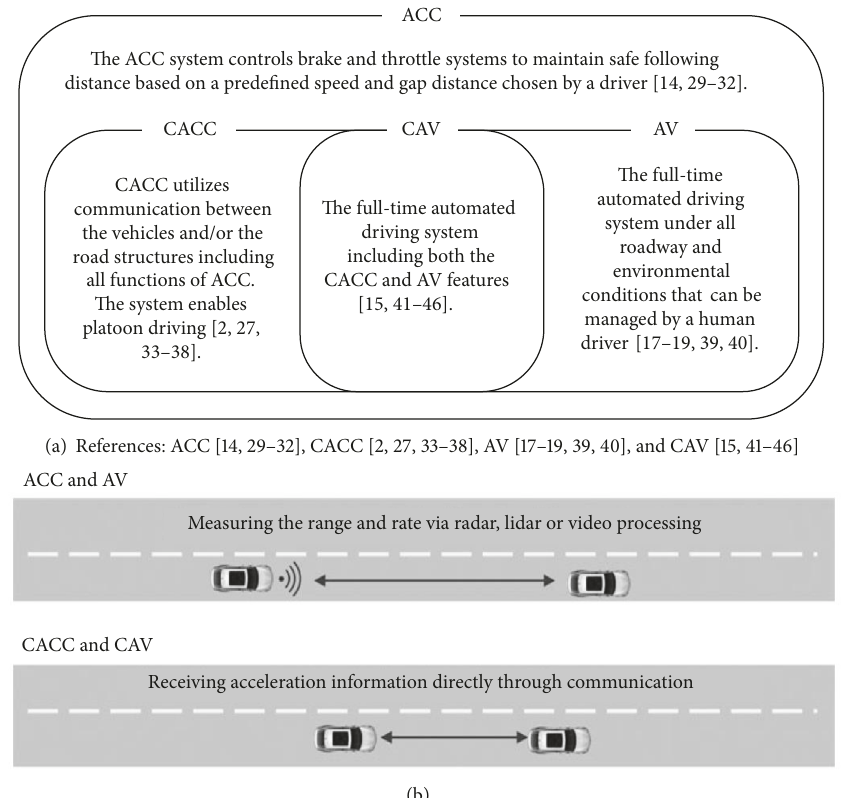
Figure 1: (a) intelligent-vehicle definitions with their classifications, (b) illustrations of sensing and communications by intelligent vehicles. Source: Figure 1(b) [18]